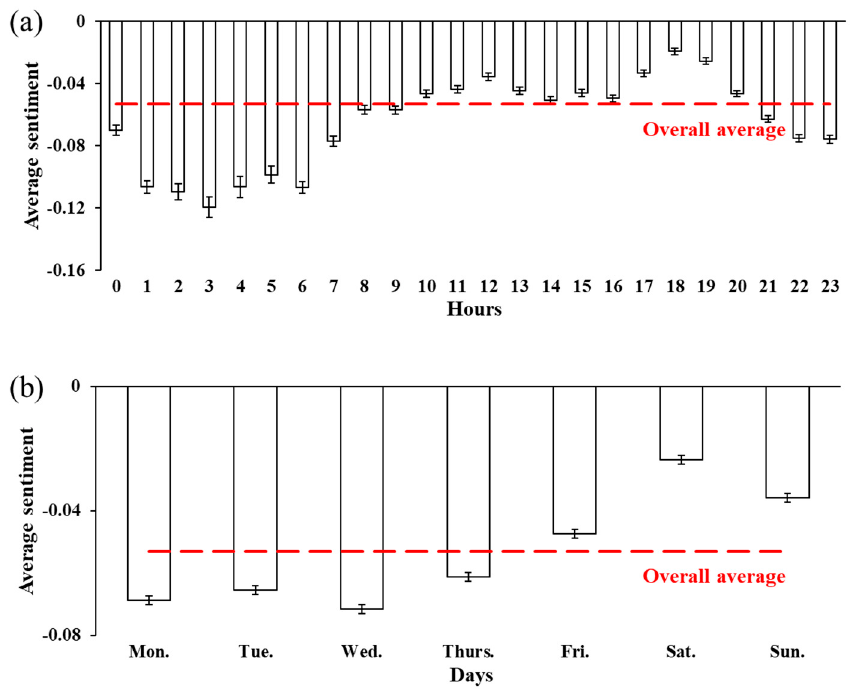
Figure 5. Average sentiment scores by ( a ) hours of the day and ( b ) days of the week. Int. J. Environ. Res. Public Health 2018 , 15 , x